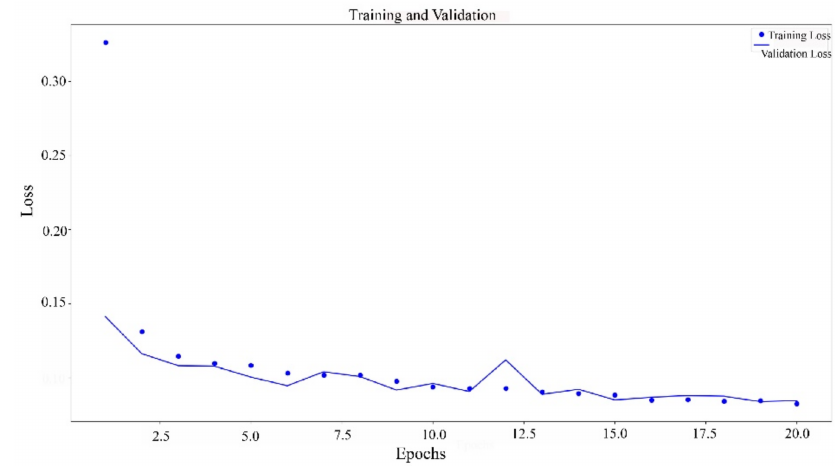
Figure 8. Variation in loss function with number of iterations.